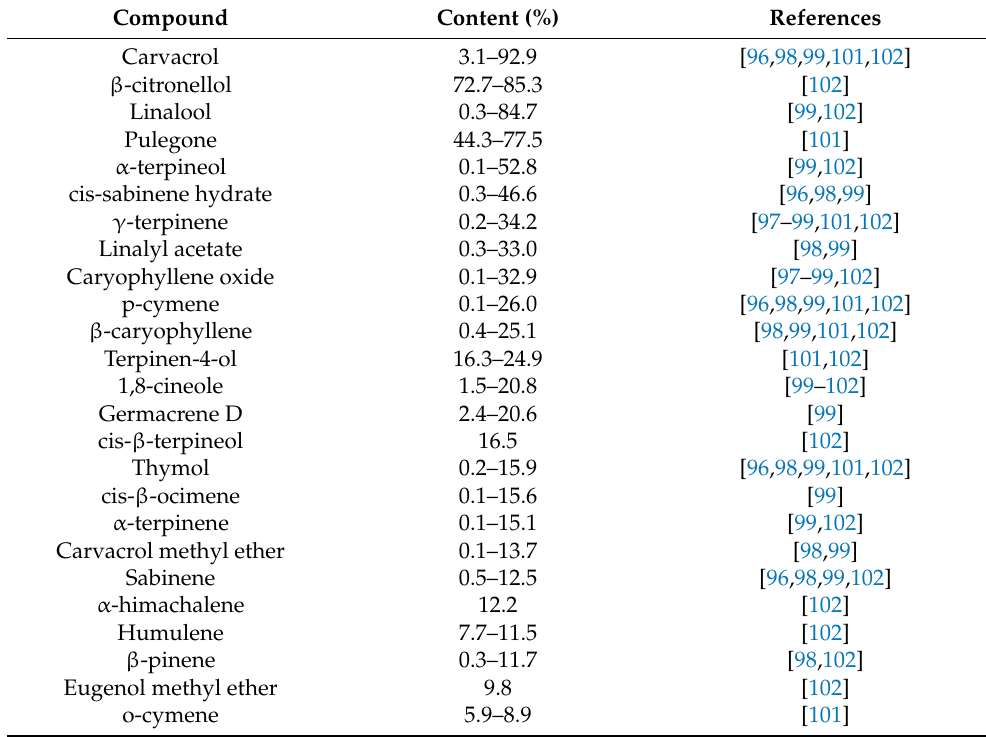
Table 5. The main compounds of the O. vulgare essential